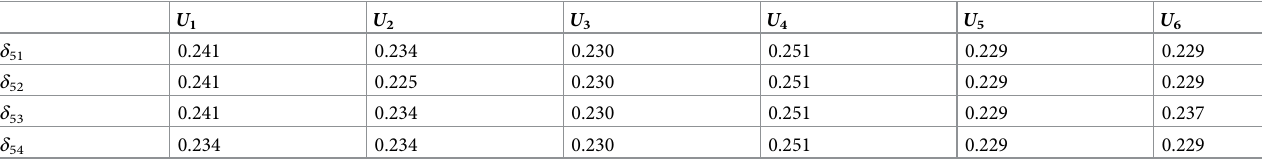
Table 13. The transformed probability of alternative O 5 to others.